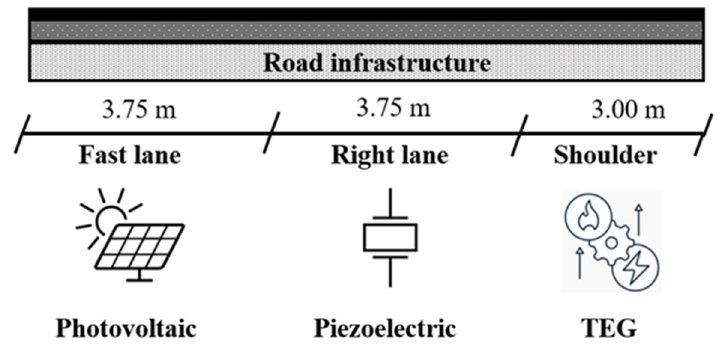
Figure 4. Sketch of the road section equipped with energy harvesting technologies.